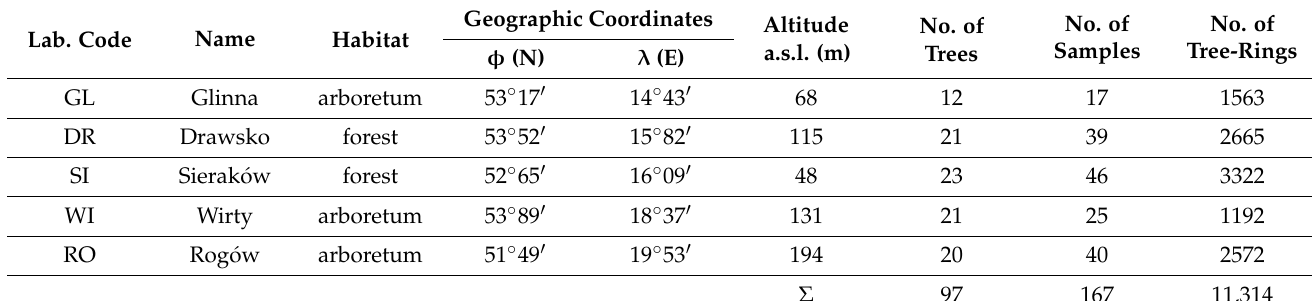
Figure 1. Study plot location. T, temperature; P, precipitation; IN, insolation. Table 1. List of study plots and basic